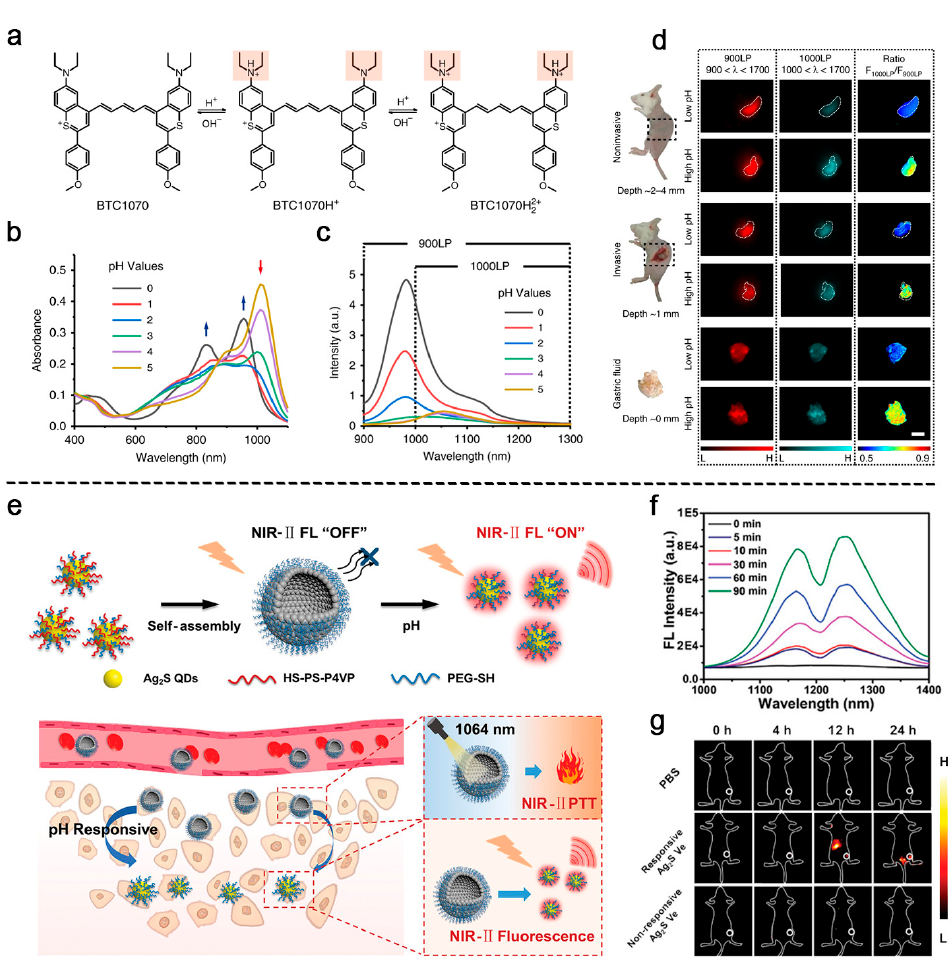
Figure 2. ( a ) Chemical structure of BTC1070 and its protonation mechanism. ( b ) Electronic absorption and ( c ) fluorescence spectra of BTC1070 in PBS at different pH conditions (excited at 808 nm). ( d ) Digital photographs of three imaging modes distinguished based on different tissue depths (left) and fluorescence imaging and ratiometric fluorescence imaging of BTC1070 in gastric juice at different pH under three imaging modes (right). Reproduced with permission [54]. Copyright 2019, Nature Publishing Group. ( e ) Schematic diagram of self-assembly process of Ag 2 S QDs into pH-activatable Ag 2 S Ve and the mechanism of pH-activatable Ag 2 S Ve for NIR-II fluorescence-imaging-guided photothermal cancer therapy in vivo. ( f ) Fluorescence spectra of pH-activatable Ag 2 S Ve triggered by low pH condition at different time points under the irradiation of 808 nm laser. ( g ) Time-dependent NIR-II fluorescence imaging of tumors in vivo after treatment with PBS and pH-activatable and non-activatable Ag 2 S Ve (10 mg/mL). Reproduced with permission [63]. Copyright 2021,